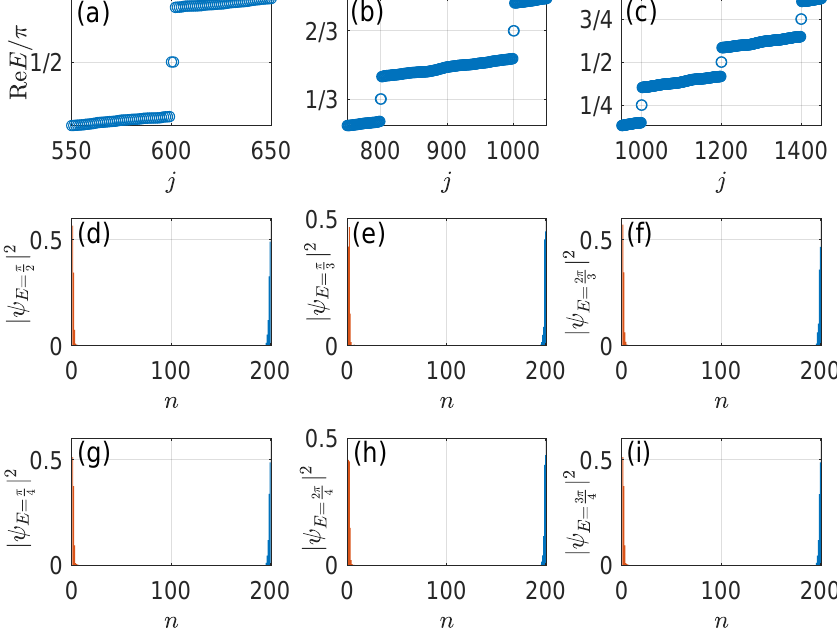
Figure 9: The real part of Floquet spectrum and fractional-quasienergy edge modes of the q th-root non-Hermitian FTIs for q = 2,3,4 with disorder. The notations, length of lattice and system parameters are the same as those used in Fig.